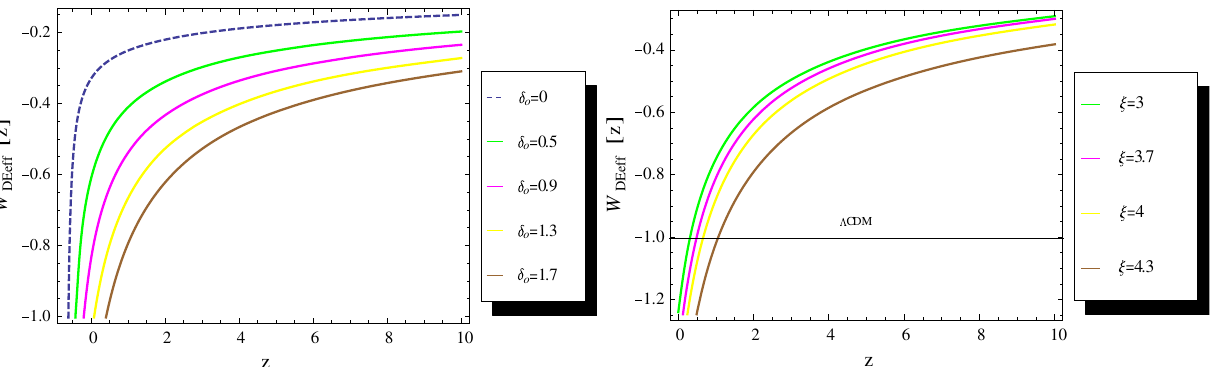
Fig. 4 ThevariationsofEoSparameter W DEef f ofviscousdarkenergy for fixed value of ξ and for δ o are respectively depicted in the graph at left-hand side and in the graph at right-hand side. The graphs are plotted